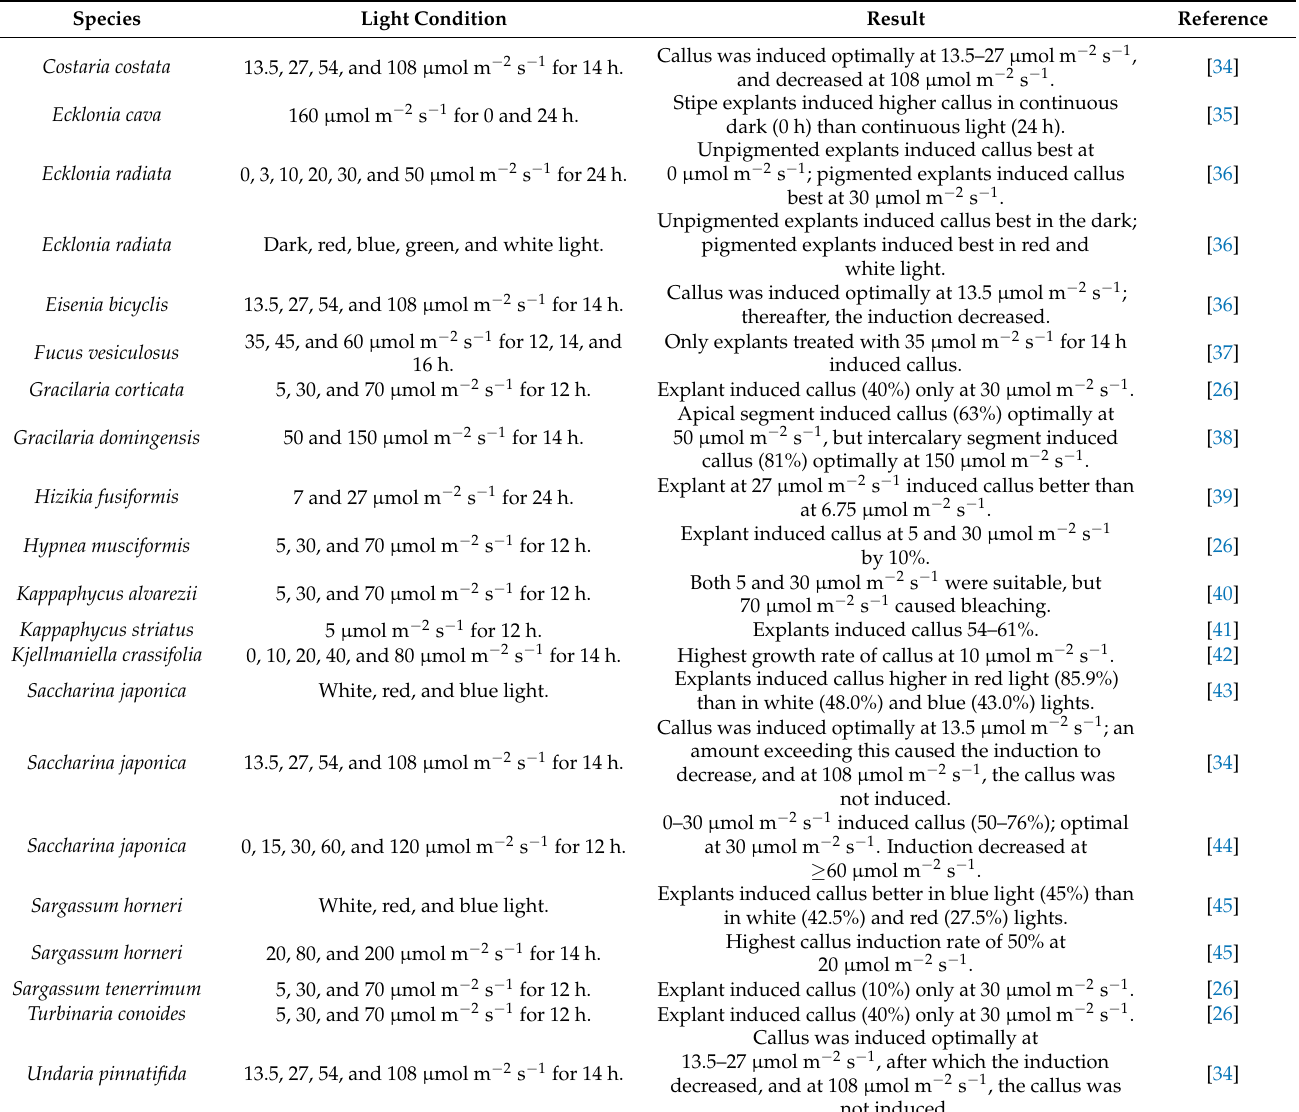
Table 1. Studies on the influence of light conditions on the callus induction of